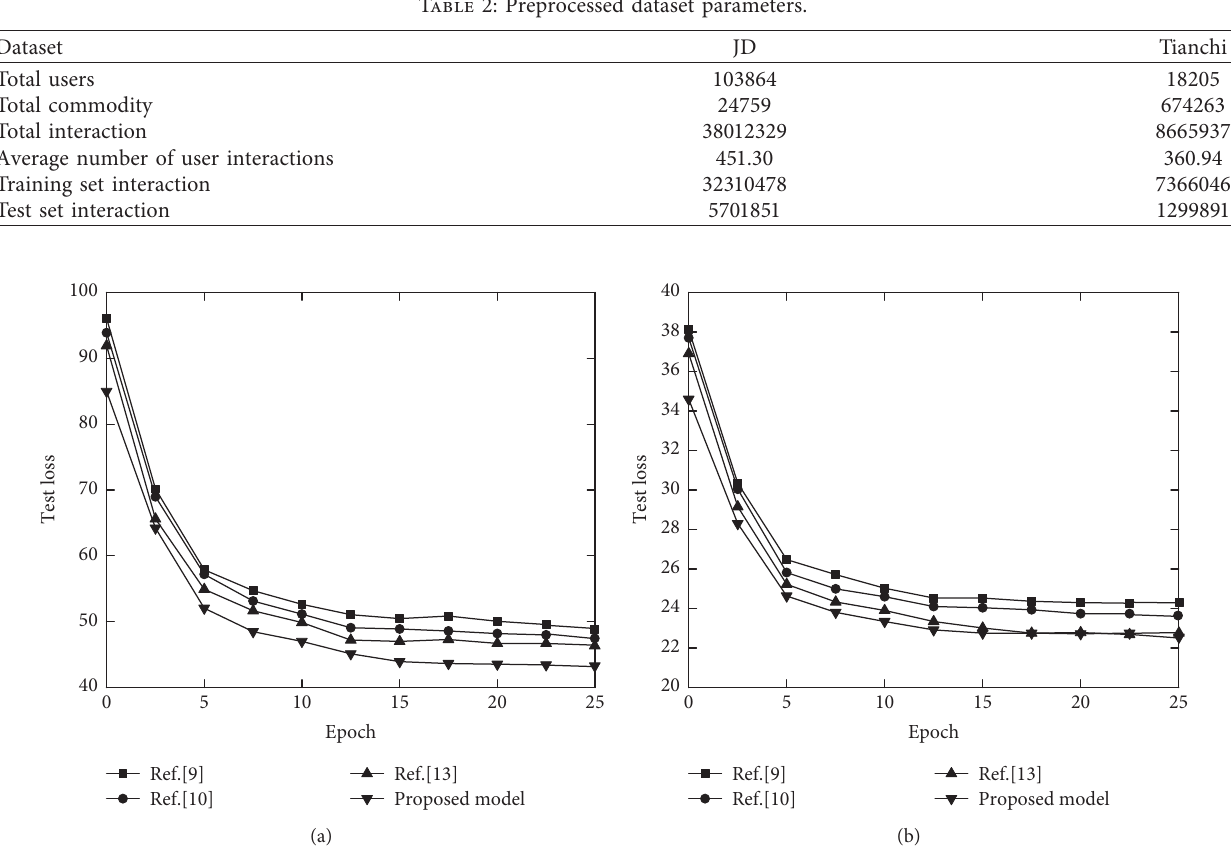
Figure 2: Test loss comparison results of different models. (a) JD dataset. (b) Tianchi